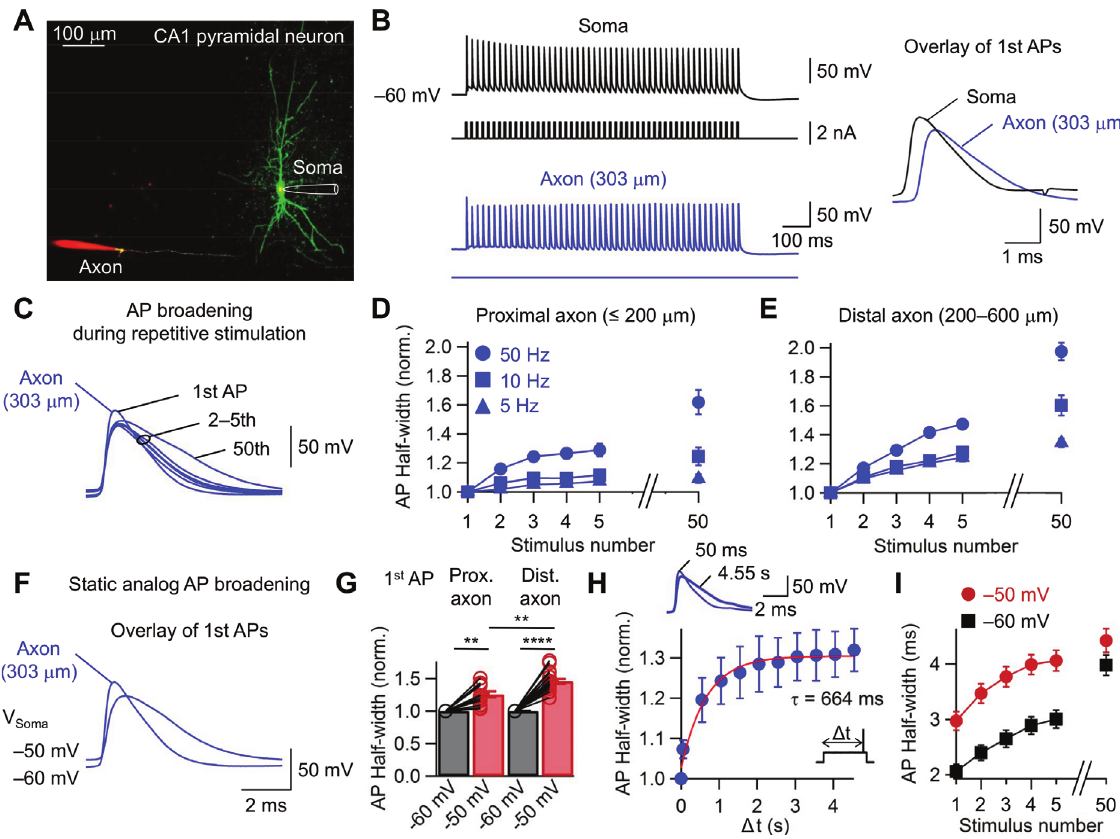
Figure 1. Activity-dependent broadening and static analog modulation of AP duration in axons of CA1 pyramidal neurons. (A) Axonal recording from a CA1 pyramidal neuron. Confocal stack maximum projection of a CA1 pyramidal neuron filled with 100 m M Alexa Fluor 488. The somatic recording pipette is illustrated schematically. Axonal recording pipettes contain 100 m M Alexa Fluor 647. (B) Left, APs evoked by a train of short pulses applied to the soma (5-ms duration, 1.5 nA amplitude, 50 Hz). Black traces indicate somatic voltage and corresponding current, blue traces represent axonal voltage and corresponding current. Right, traces show first action potential in the train on an expanded timescale. Axonal recording site is 303 m m from the soma. (C) Overlay of 1–5th, and 50th axonal AP in the train evoked by brief current pulses applied to the soma.